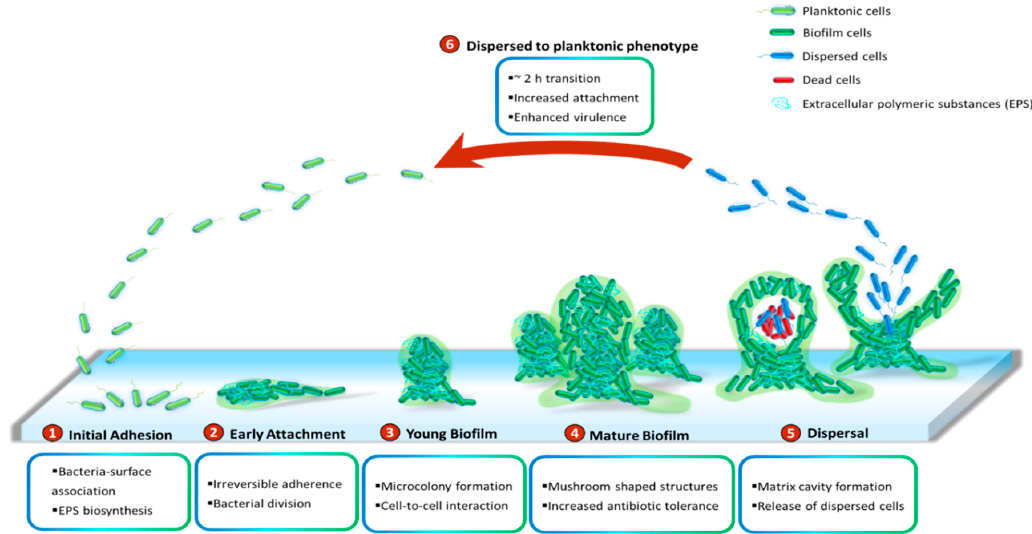
Figure 1. Cycle of P. aeruginosa biofilm development. The development cycle is divided into six stages. Initially, the bacteria associate with the surface and produce extracellular polymeric substances (EPS) including proteins, polysaccharides, lipids and eDNA. Next, cell division and the transition of reversible attachment into irreversible take place. The following steps are the formation of microcolonies and the further development of these microcolonies into mushroom-shaped